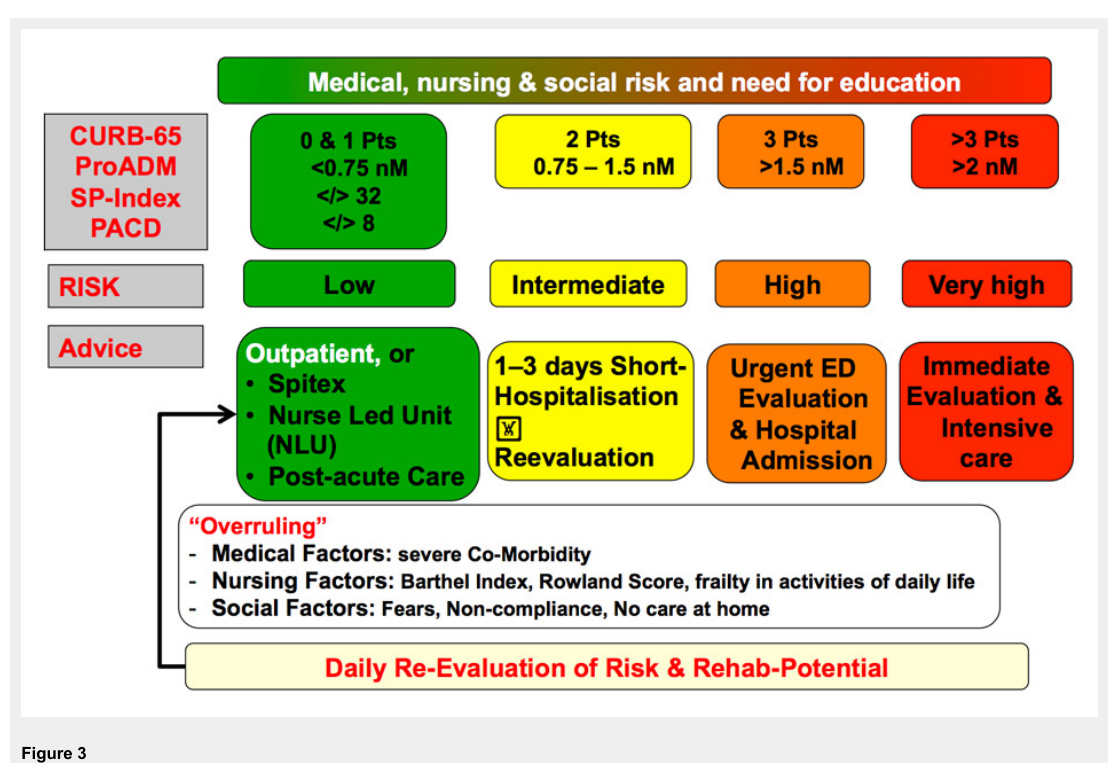
CURB-A score combining the traditional CURB-65 criteria with levels of proADM to risk stratify site-of-care decisions in patients with lower respiratory tract infections. ICU = intensive care unit; ProADM = pro-adrenomedullin; SP = Selbstpflege (self-care); PACD = post-acute care